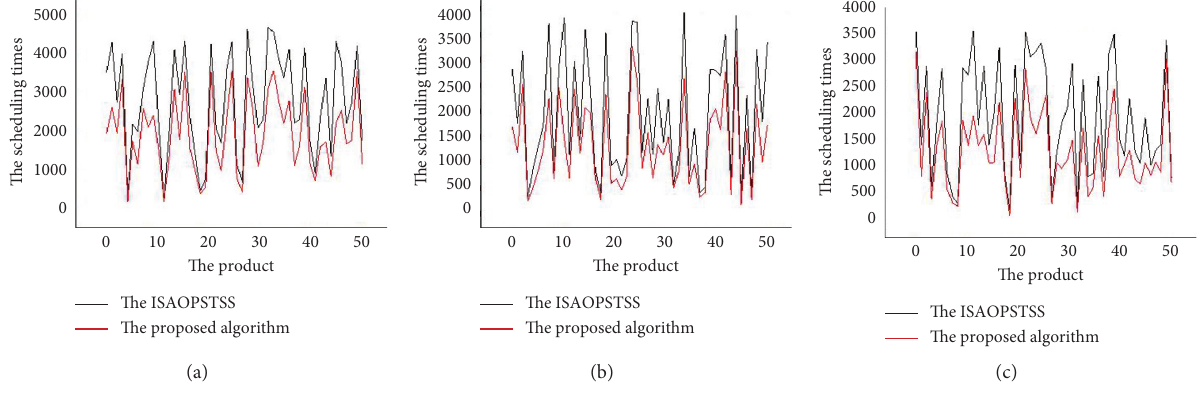
Figure 8: Comparison of scheduling times when the total number of processes is 100. (a) The scheduling times of 100 processes in 3 devices. (b) The scheduling times of 100 processes in 6 devices. (c) The scheduling times of 100 processes in 9 devices.